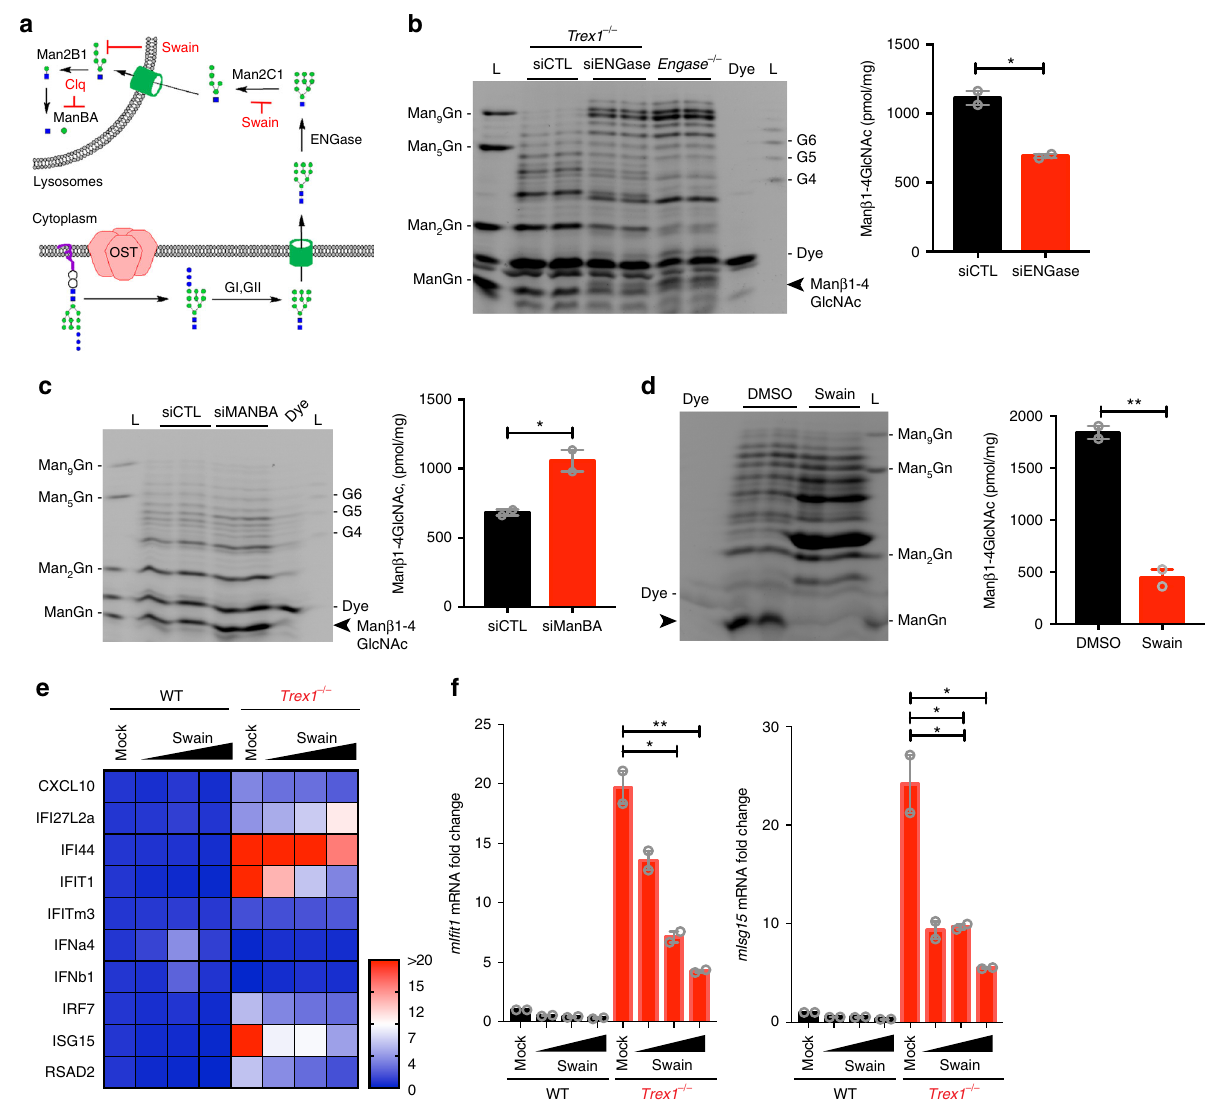
Fig. 3 The Man β 1-4GlcNAc disaccharide biogenesis requires processing by ENGase and α -mannosidase. a A schematic diagram of the catabolic processing of luminal fOS and pharmacological inhibitors (red) that blocks each step. b FACE analysis of fOS pool isolated from Trex1 − / − MEFs treated with si-control or si-ENGase for 48 h or fOS pool isolated from untreated Engase − / − MEFs. Quanti fi cation of the Man β 1-4GlcNAc disaccharide is shown on the right (same below). c FACE analysis of fOS pool isolated from Trex1 − / − MEFs treated with si-control or si-ENGase for 48 h. Similar to B. d FACE analysis of fOS pool isolated from Trex1 − / − MEFs treated with 10 μ M Swain for 24h. e , f Quantitative RT-PCR array analysis of immune gene expression in WT and Trex1 − / − E15.5 primary MEFs treated with mock or Swain (0.1, 1, and 10 μ M) for 24 h. A heat map summarizing multiple immune genes is shown in e and two representative ISGs are shown in f . Data are representative of at least three independent experiments. Error bars indicate SEM. Unpaired t and Sting − / − mice. We found that wild-type, Ifnar1 − / − , Myd88 − / − Trif − / − and Mavs − / − BMDMs responded to the Man β 1-4GlcNAc disaccharide stimulation to similar levels. In contrast, Tbk1 Δ / Δ BMDMs completely ablated immune response to Man β 1-4GlcNAc while Sting − / − and Irf3 − / − Irf7 − / − partially